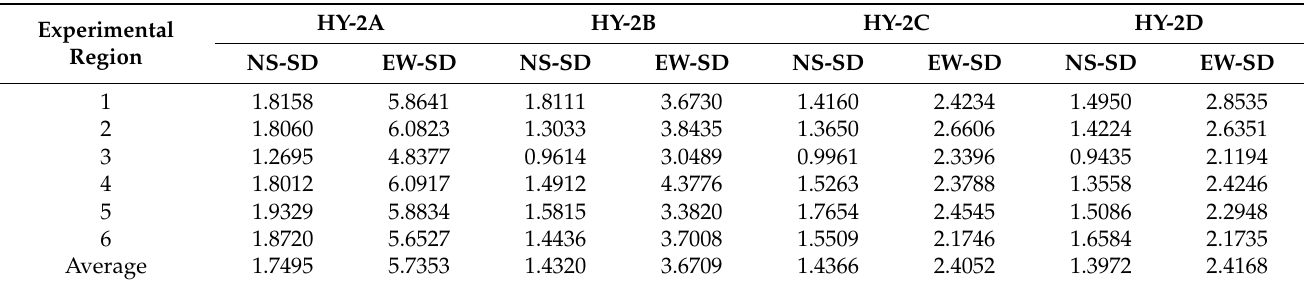
Table 6. Validation for directional components of vertical deflection at crossover points with